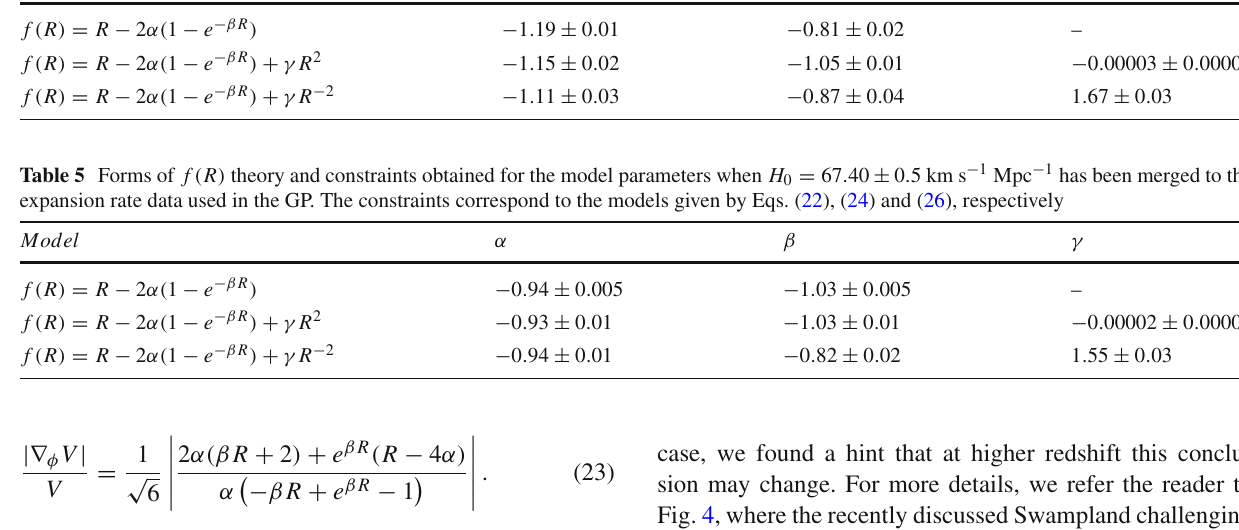
Table 4 Forms of the f ( R ) theory and constraints obtained for the model parameters, when H 0 = 73 . 52 ± 1 . 62 km s − 1 Mpc − 1 has been merged to the expansion rate data used in the GP. The constraints correspond to the models given by Eqs. (22), (24) and (26), respectively Model